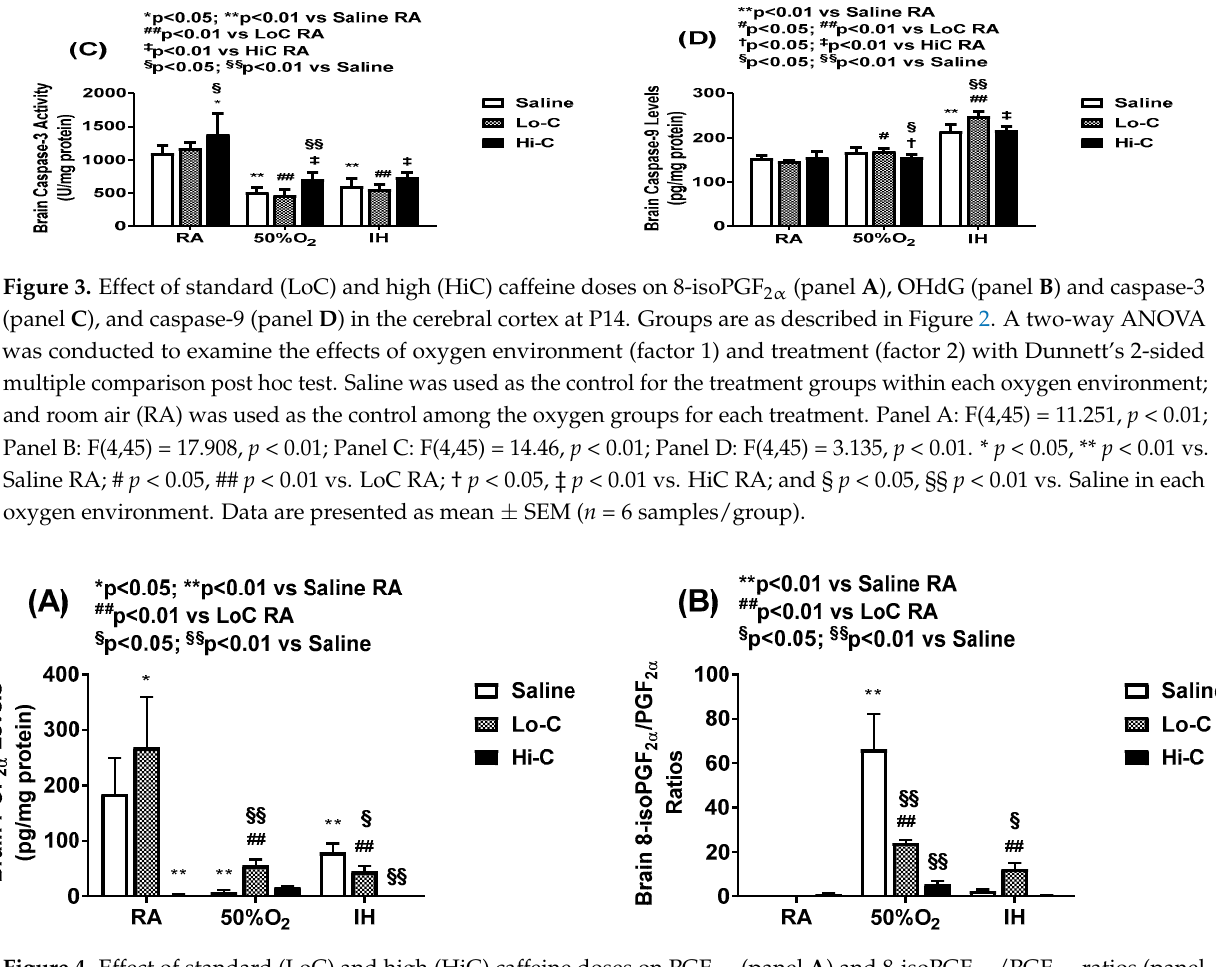
Figure 4. Effect of standard (LoC) and high (HiC) caffeine doses on PGF 2 α (panel A ) and 8-isoPGF 2 α /PGF 2 α ratios (panel B ) in the cerebral cortex at P14. Groups are as described in Figure 2. A two-way ANOVA was conducted to examine the effects of oxygen environment (factor 1) and treatment (factor 2) with Dunnett’s 2-sided multiple comparison post hoc test. Saline was used as the control for the treatment groups within each oxygen environment; and room air (RA) was used as the control among the oxygen groups for each treatment. Panel A: F(4,45) = 6.4251, p < 0.01; Panel B: F(4,45) = 34.985, p < 0.01. * p < 0.05, ** p < 0.01 vs. Saline RA; ## p < 0.01 vs. LoC RA; and § p < 0.05, §§ p < 0.01 vs. Saline in each oxygen environment. Data are presented as mean ± SEM (n = 6 samples/group).